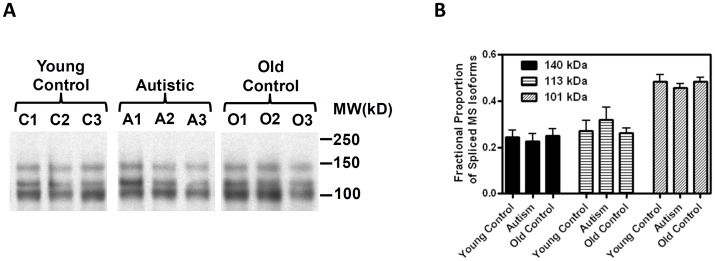
MS protein status in human cortex.(A) Western blot analysis of MS protein revealed three primary bands with approximate MW values of 140, 113 and 101 kDa. A similar pattern was observed for young control subjects, age-matched autistic subjects, and elderly subjects. (B) Quantification of western blot data. The density of the three MS variants was not significantly different between the three groups (n = 8).